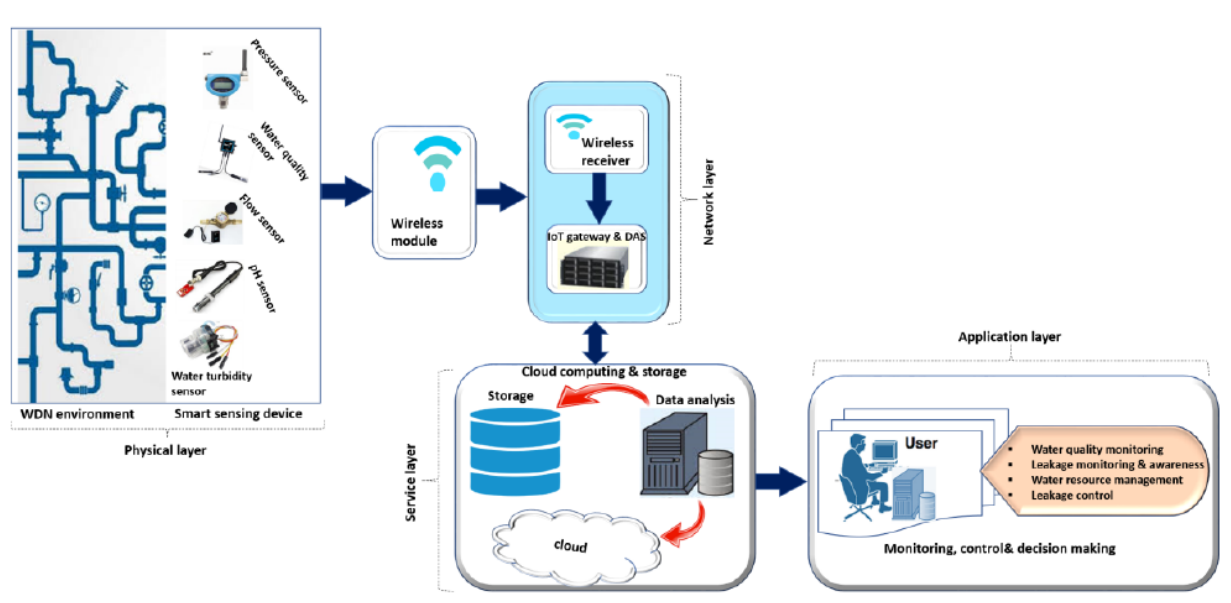
Figure 11. SWNM application framework [149].